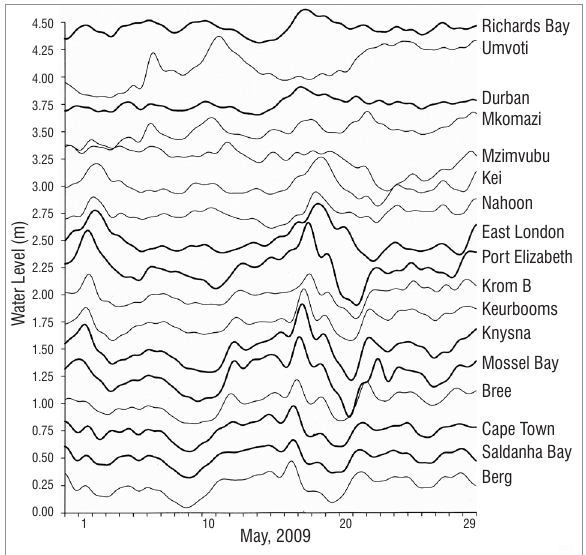
Figure 5: Water level measurements at ports around South Africa (dark lines) and at selected estuaries (light lines) for a 30-day period in 2009. The water level series have been displaced vertically to ensure visibility. a